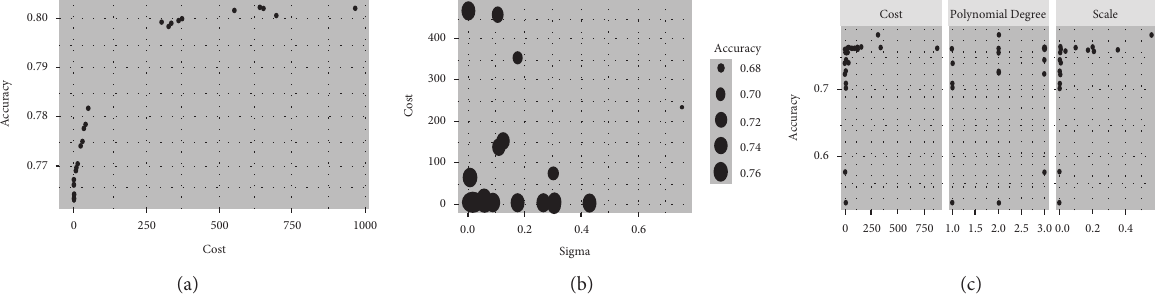
Figure 4: Optimized parameter selection using the grid search technique for Nikkei 225 index with (a) linear kernel, (b) RBF kernel, and (c) polynomial kernel.